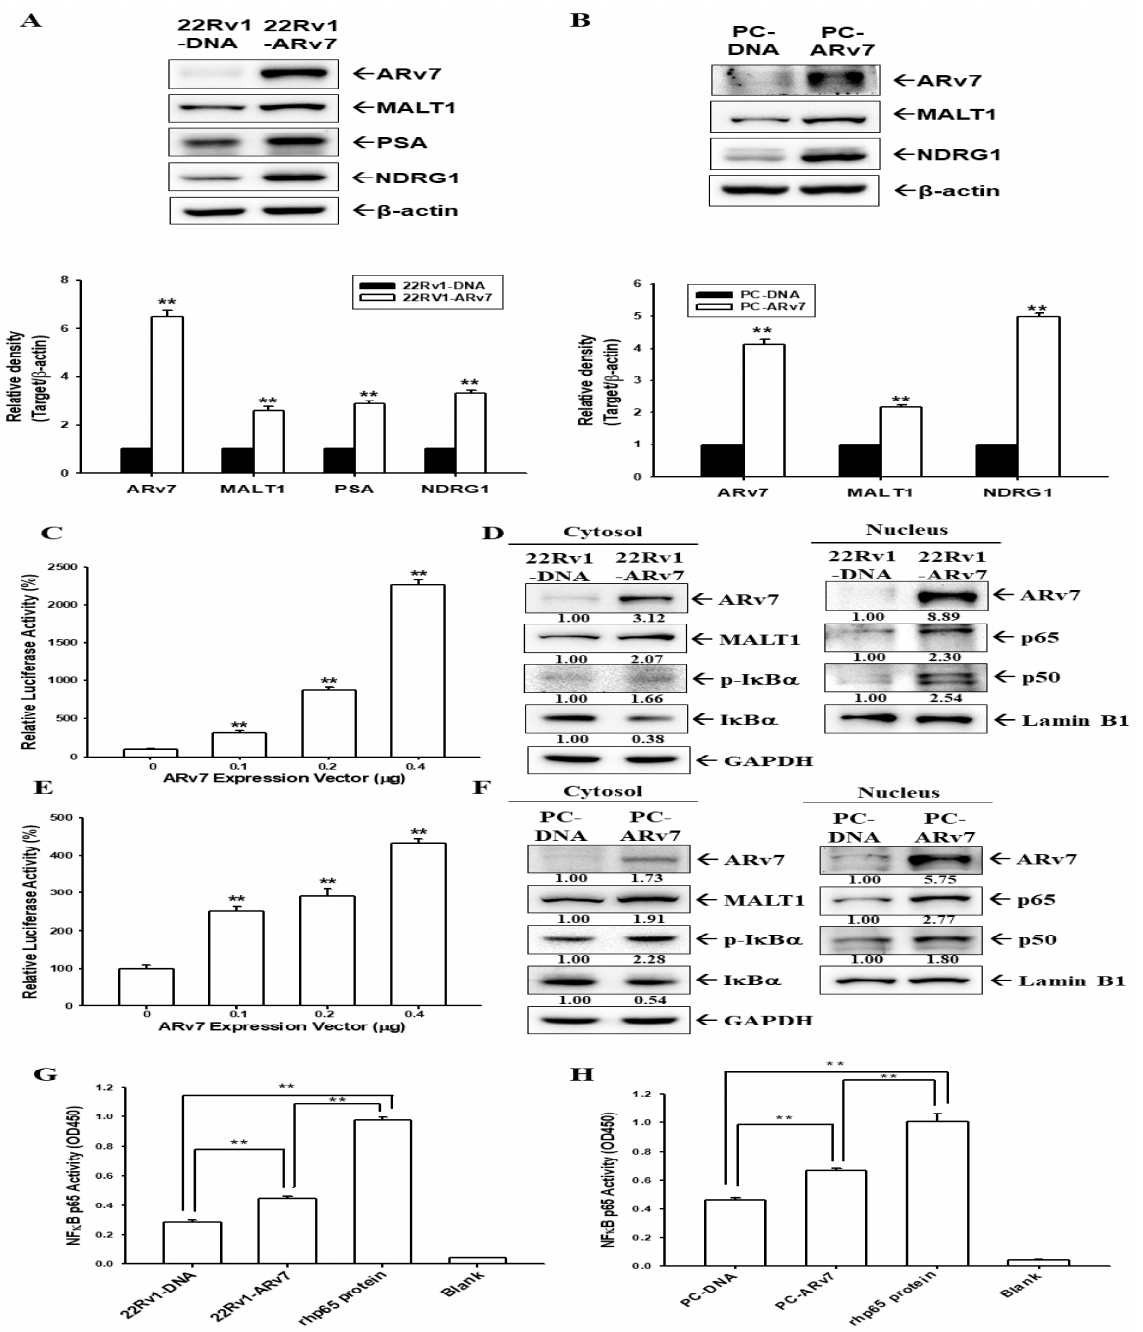
Figure 5. Ectopic overexpression of ARv7 upregulates MALT1 expression to enhance NF- κ B activation in PC-3 and 22Rv1 cells. An immunoblot assay of the expression of ARv7, MALT1, PSA, NDRG1, and β -actin in 22Rv1 ( A ) and PC-3 ( B ) cells. The quantitative data of the immunoblot assays were presented as the mean fold induction ( ± SE, n = 3) of the target proteins/ β -actin relative to the mock-transfected group. The reporter activity of the MALT1 reporter vector was cotransfected with various concentrations of the ARv7 expression vectors, as indicated, for 24 h in the 22Rv1 ( C ) and PC-3 ( E ) cells. The data are presented as mean percentages ( ± SE, n = 6) relative to the control vehicle-treated group. The expression of ARv7, MALT1, I κ B α , phospho-I κ B α , p65, p50, Lamin B1, and GAPDH in the 22Rv1 ( D ) and PC-3 ( F ) cells after the separation of the nuclear and cytoplasmic fractions, as indicated, were determined by immunoblot assays. The numbers indicate the ratio of target proteins/GAPDH or Lamin B1 in relation to the mock-transfected group. The NF- κ B (p65)-binding activity in the 22Rv1 ( G ) and PC-3 ( H ) cells after stably transfecting with ARv7. ** p <